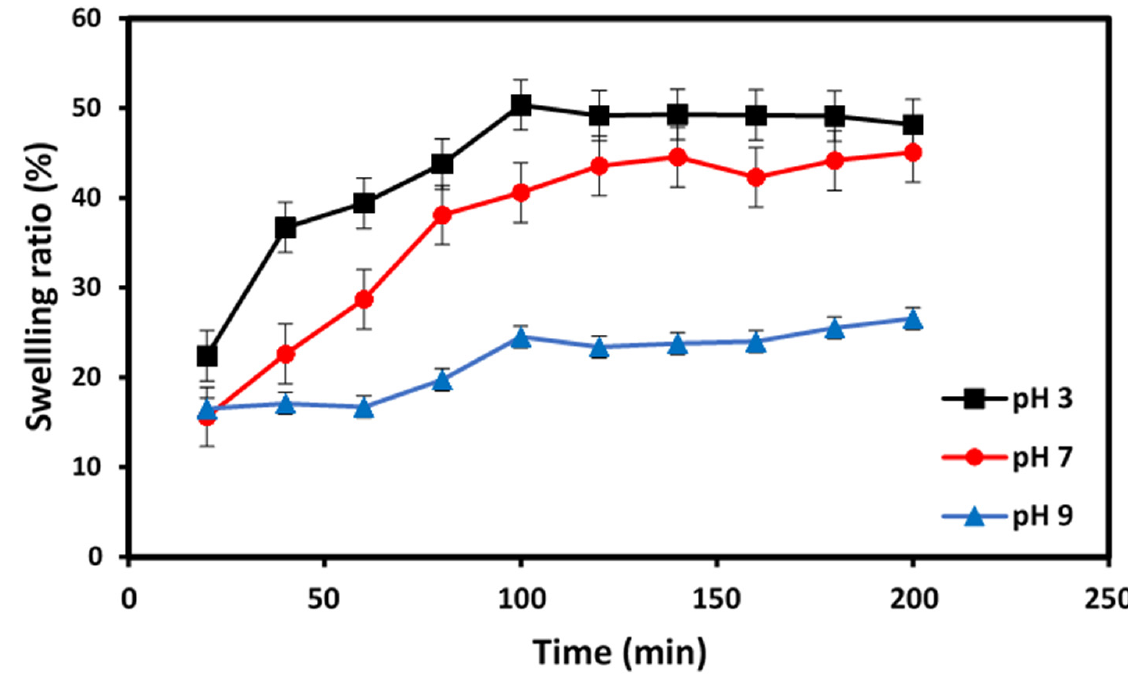
Figure 5. Swelling behavior of PVA-CS/CE composite hydrogel beads at di ff erent pH values.